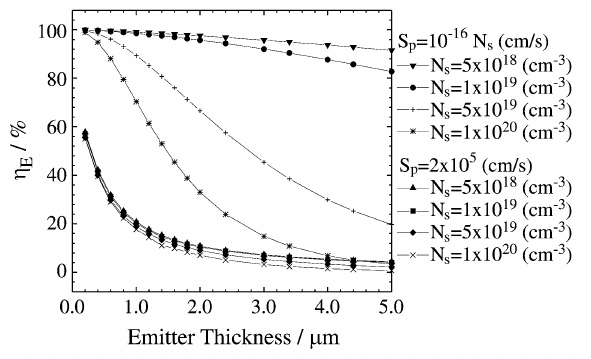
Figure 2. Emitter collection efficiency ( η E ) vs. emitter thickness, admit- ting different doping levels (N s ) and two kinds of surfaces (passivated and non-passivated).